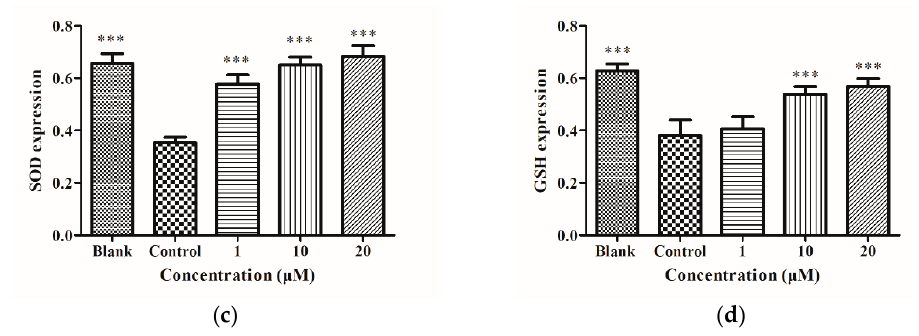
Figure 3. ( a ) Effect of DIF on superoxide dismutase (SOD), glutathione (GSH), and γ‐ glutamyl transferase (GGT) proteins levels in ethanol ‐ induced HepG2 cells. Cells were treated with DIF (1, 10, and 20 μ M) for 2 h, and then treated with 0.5 M ethanol for 24 h. GAPDH was used as an internal control. Protein expression (relative to GAPDH) was evaluated. ( b ) GGT protein expression was evaluated. ( c ) SOD protein expression was evaluated. ( d ) GSH protein expression was evaluated. Data are shown as mean ± SD (n = 3). *** Compared with the control group, p < 0.001.